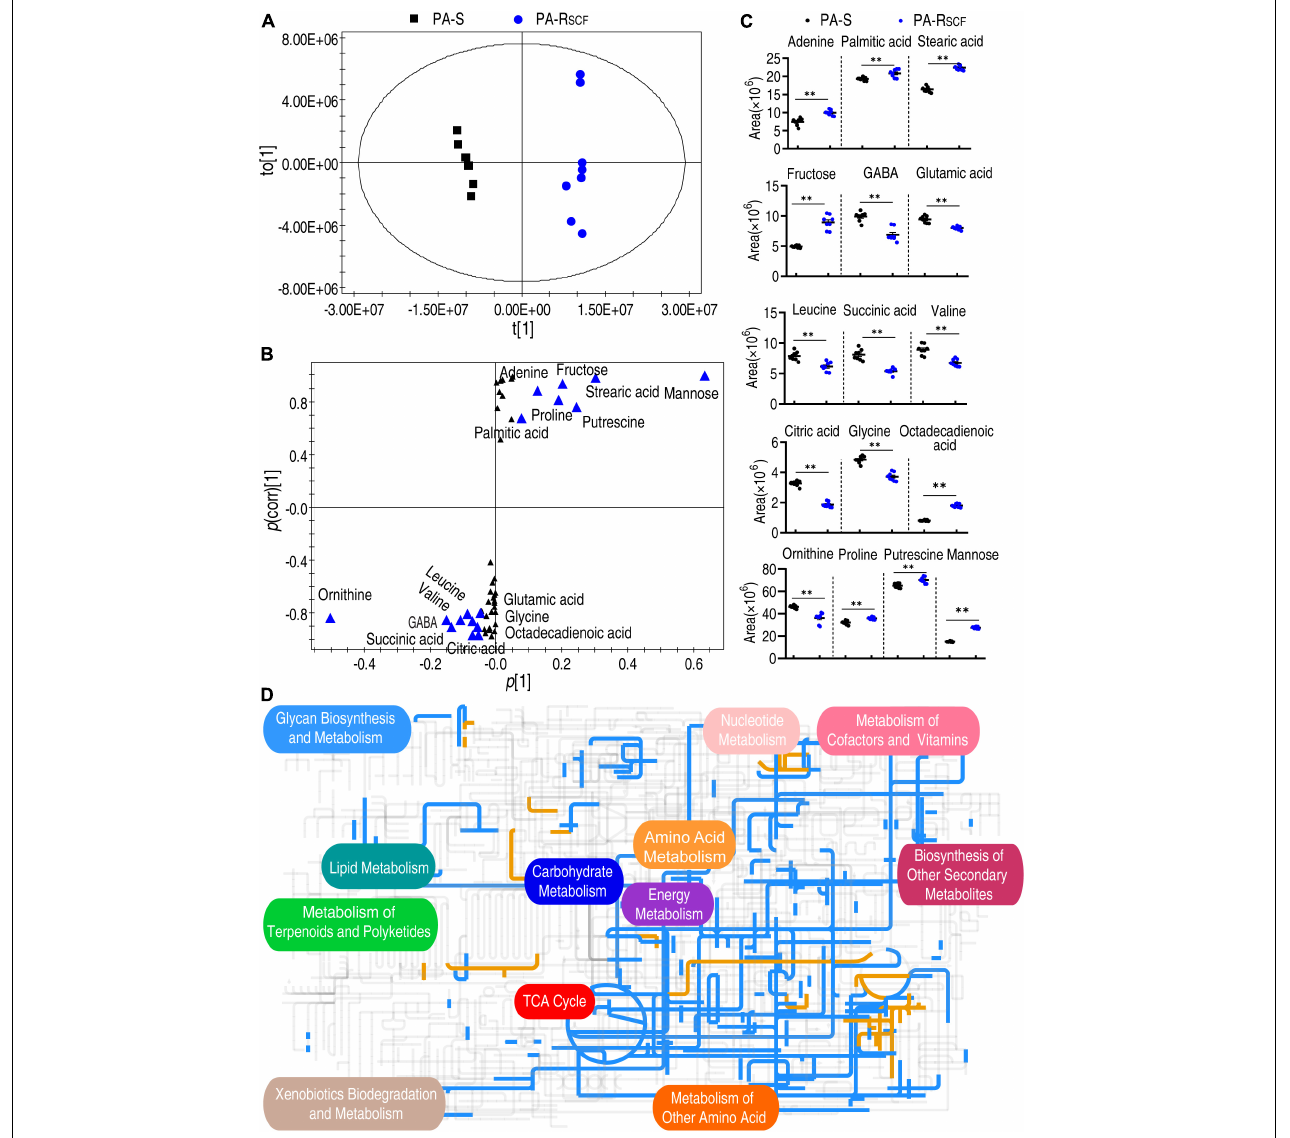
FIGURE 4 | Identification of biomarkers and iPath analysis in PA-R SCF . (A) The PCA analysis between PA-S and PA-R SCF . Each dot represents the technique replicas in the plot. (B) S-plot generated from OPLS-DA. Triangle represents individual metabolite, where potential biomarkers are highlighted with blue, which is greater than or equal to 0.05 and 0.5 for absolute value of covariance p [1] and correlation p (corr) [1], respectively. (C) The scatter plot of biomarkers in data (B) . (D) iPath analysis. Blue and yellow lines represent decreased and increased metabolisms, respectively. Out of 49 significant metabolites ( p < 0.05), 46 were submitted to the online website